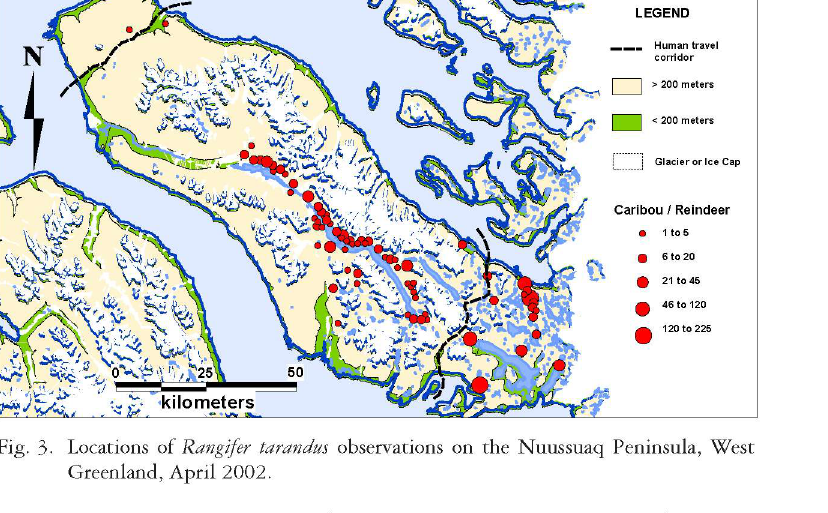
Fig. 3. Locations of Rangifer tarandus observations on the Nuussuaq Peninsula,